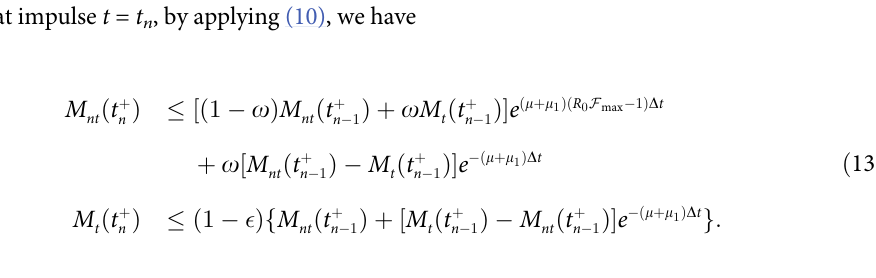
and M are 2.6274 × 10 − 4 and 2.9925 × 10 − 5 , respectively. (d) k = 0.2, R 0 = 2 and MSE nt t